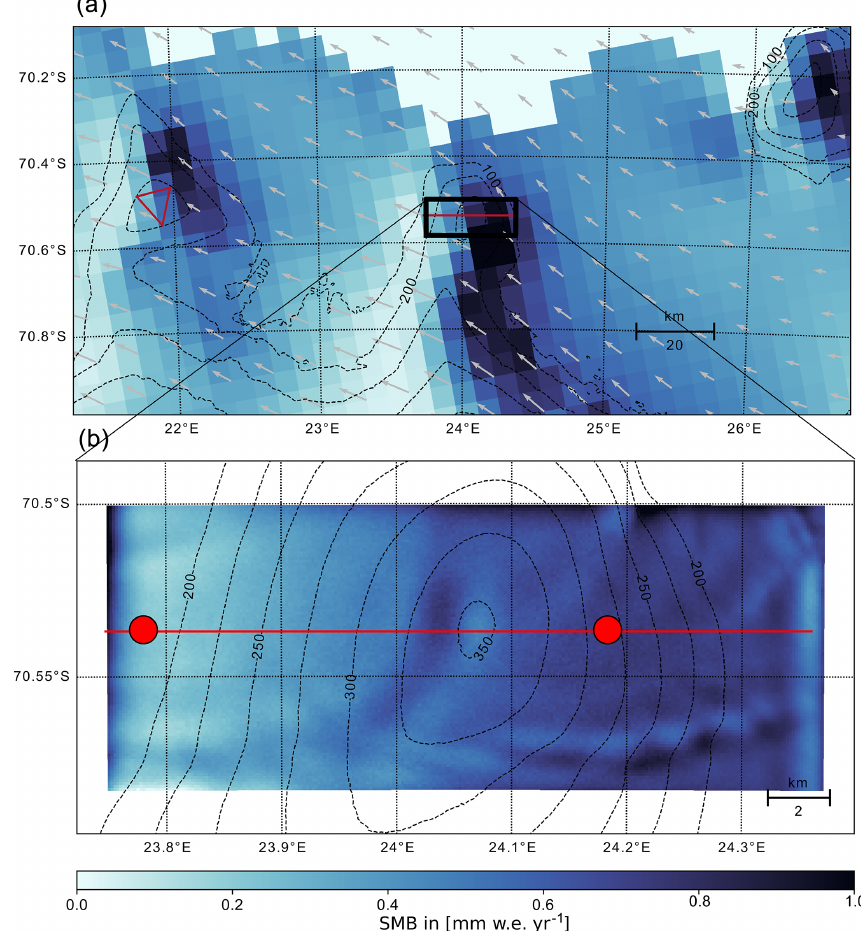
Figure 4. Overlays of the SMB modeled by RACMO2 (a) and SnowModel (b) for the time period of 2011 to 2017 with topography contour lines based on the 90m TanDEM-X digital elevation model (© DLR 2018) and RACMO2 wind vectors (gray arrows). The simulated area by SnowModel is marked in (a) with a black box. The red lines show the location of the recorded GPR